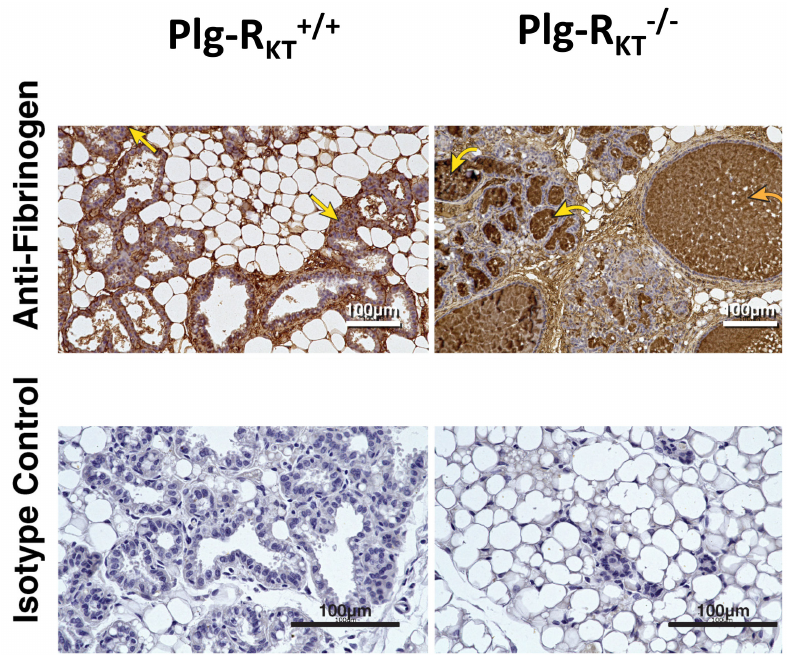
Figure 6. Plg-R KT deletion alters the ECM in lactating mammary glands. Abdominal mammary glands were harvested from Plg-R KT+/+ and Plg-R KT − / − female mice two days postpartum and stained with anti-fibrin(ogen) antibody (the curved yellow arrow labels represent fibrin deposition in alveoli; the curved orange arrow labels represent fibrin deposition in dilated ducts; the straight yellow arrows labels represent fibrin deposition in adipose tissue) or non-immune rabbit IgG control. This re- search was originally published in Miles, L.A.; Baik, N.; Bai, H.; Makarenkova, H.P.; Kiosses, W.B.; Krajewski, S.; Castellino, F.J.; Valenzuela, A.; Varki, N.M.; Mueller, B.M.; Parmer, R.J. The plas- minogen receptor, Plg-RKT, is essential for mammary lobuloalveolar development and lactation. J. Thromb. Haemost. 2018 , 16 , 919–932. [83] Reprinted with permission from John Wiley and